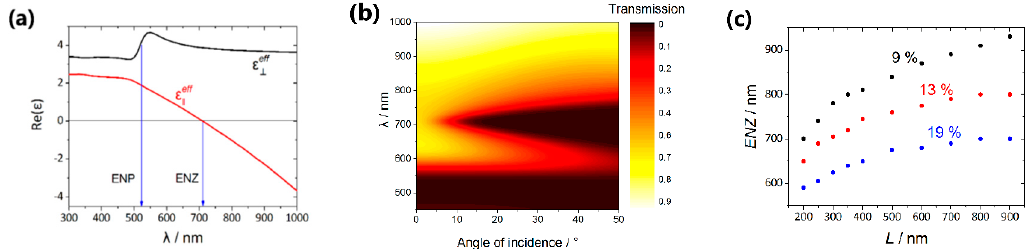
Figure 5. Calculation results. ( a ) Spectra of the permittivity components ε ef f ⊥ (black curve) and ε ef f (cid:107) (red curve) for the sample s50_289 nm with volume fractions of air, alumina, and metal of about 11%, 76%, and 13%, respectively. The nanorods length of 290 nm was taken; ( b ) angular-wavelength transmission spectrum for the sample s50_289 nm; ( c ) dependence of the ENZ spectral position on the length of the nanorods, the volume fraction of alumina is 76%, the volume fraction of gold is 9% (black points), 13% (red points) and 19% (blue points).